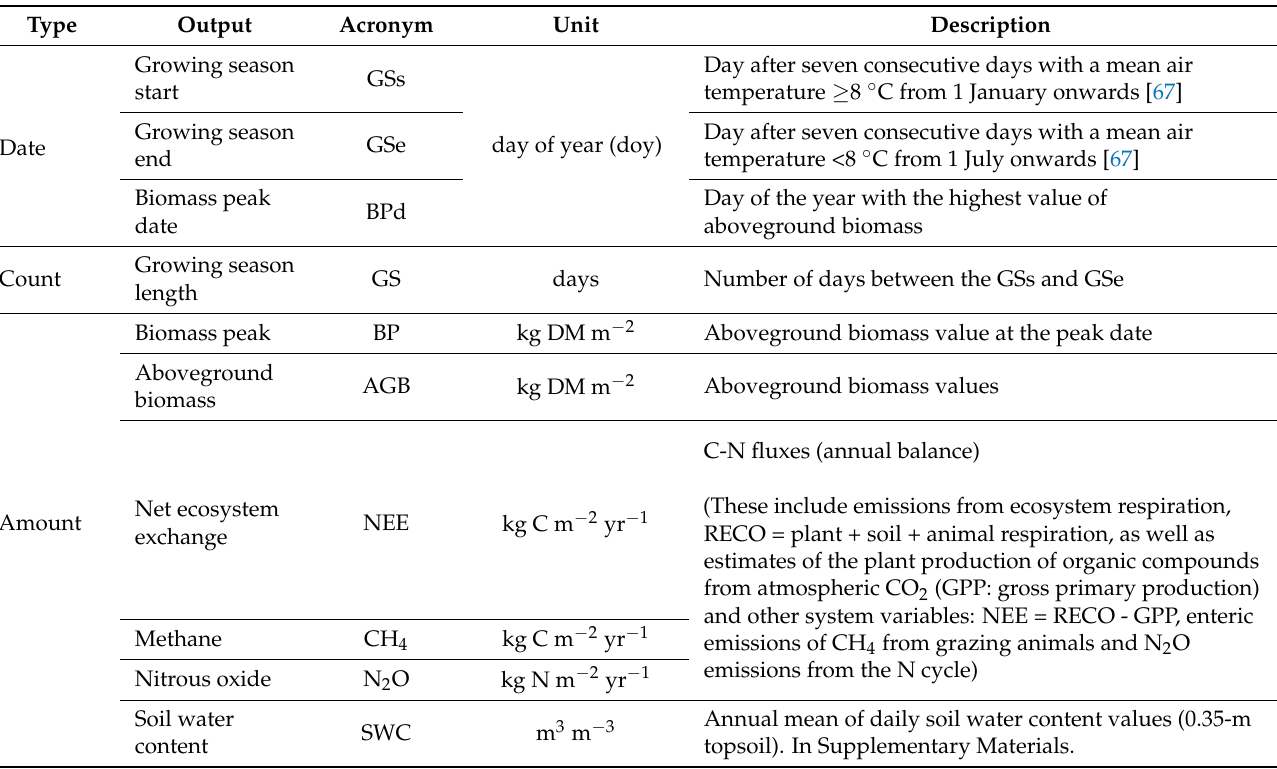
Table 3. Climate change impact